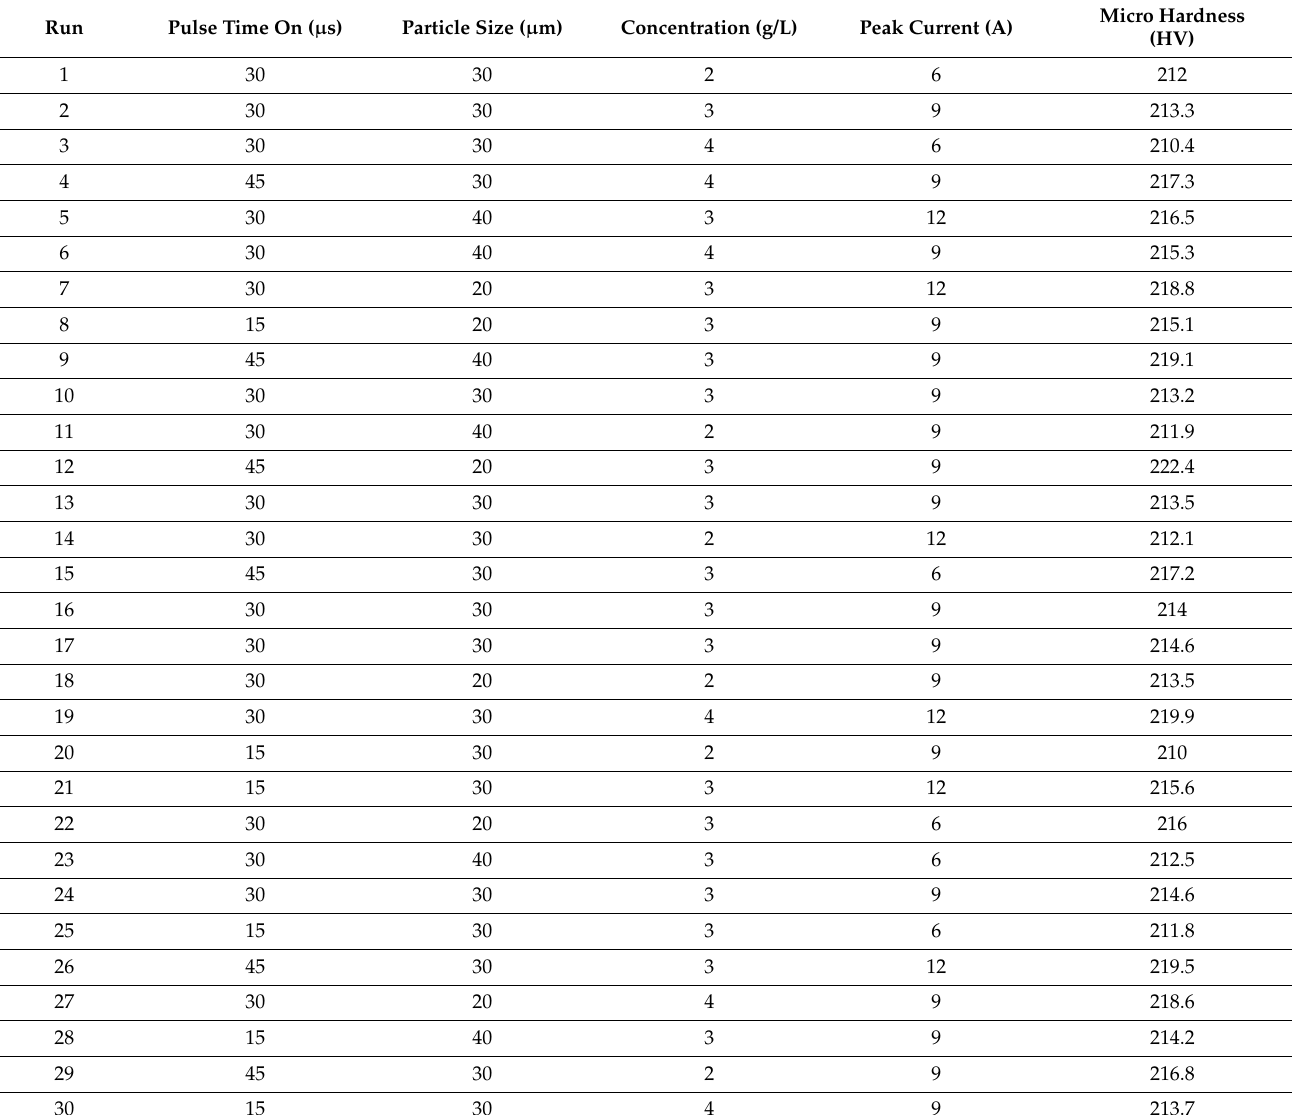
Table 8. Vickers micro hardness results.